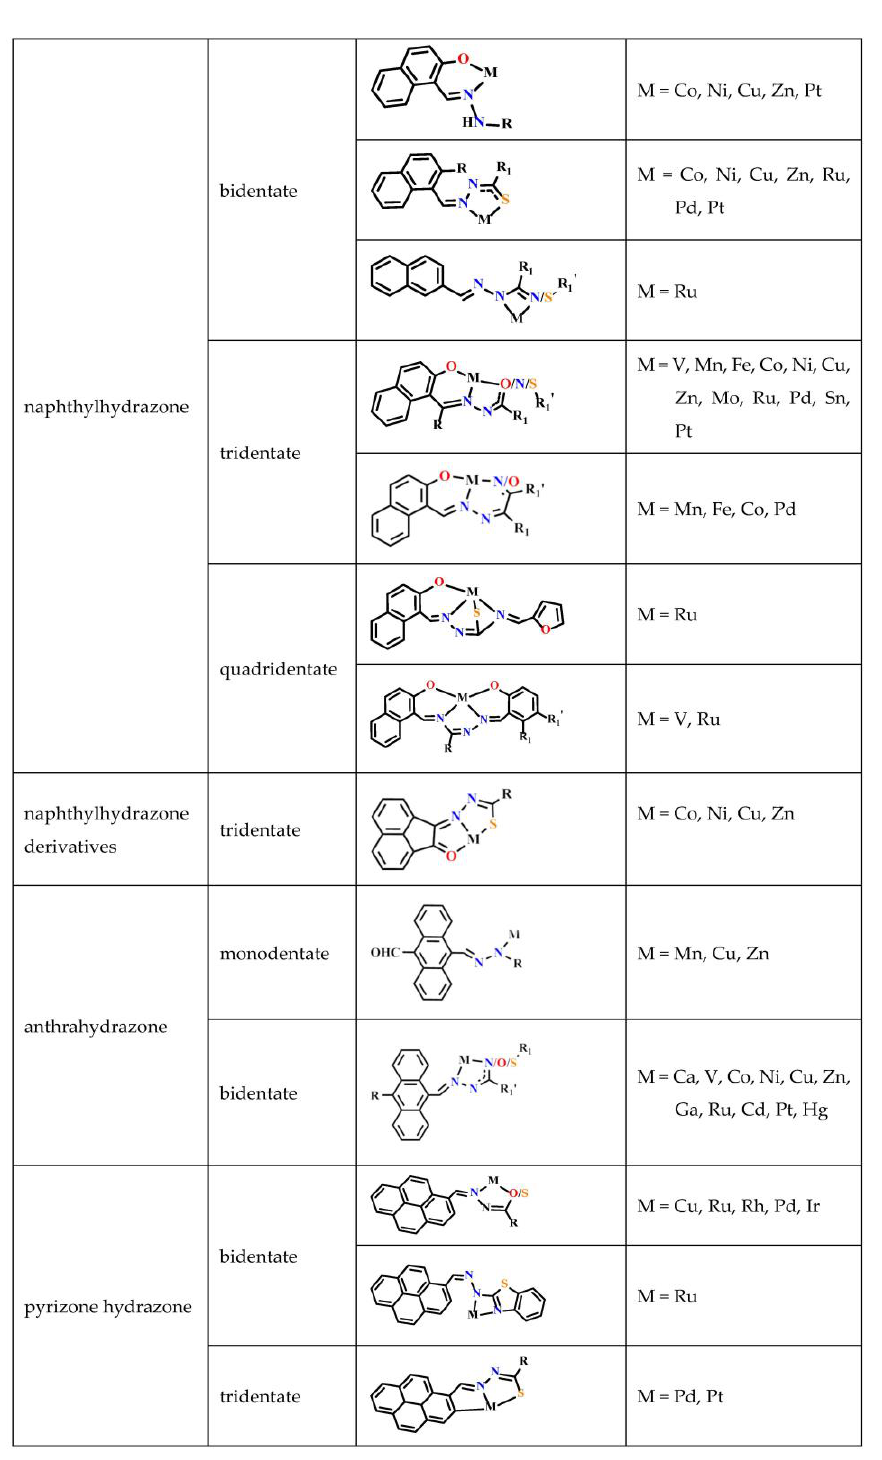
Scheme 1. An overview scheme showing various coordination modes of most of the polycyclic aromatic hydrazone metal complexes mentioned within.